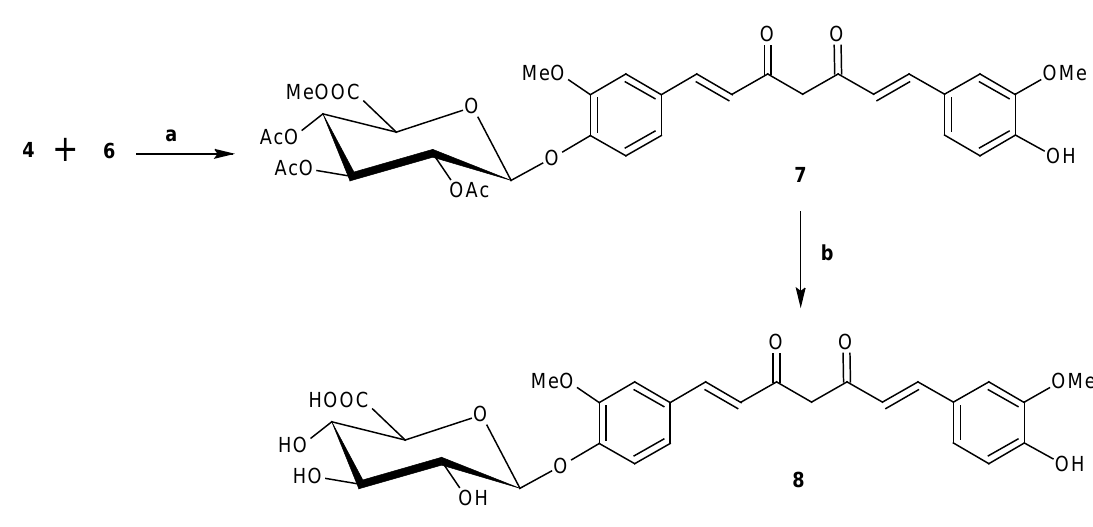
Scheme 3. Synthesis of mono-(β- D -glucopyranosiduronic acid)-curcumin (curcumin- monoglucuronide) ( 8 ). Reagents: (a) B 2 O 3 , (sBuO) 3 B, n -BuNH 2 , DMF, 75–80 °C, 6 h,